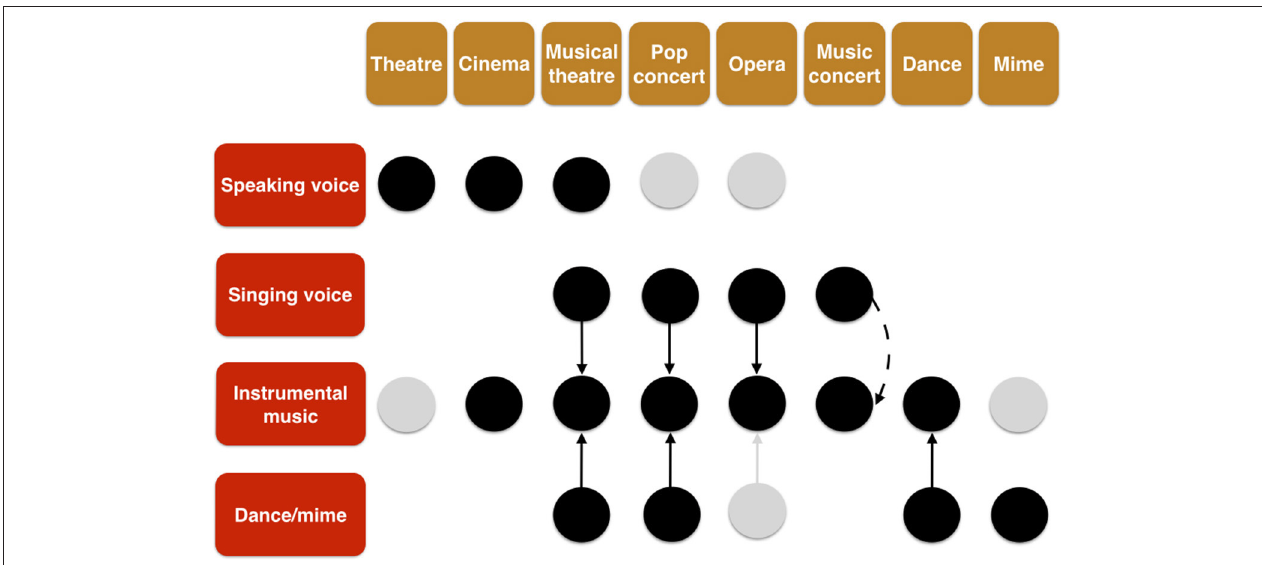
FIGURE 3 | The performing arts with respect to performance modalities. The figure shows eight forms of the performing arts along the top. These are then classified with respect to their inclusion of four performance modalities: the speaking voice, the singing voice, instrumental music, and dance (and/or mime). Black circles imply the presence of a given modality in a given artform. The vertical arrows suggest that singing and dancing are very often done to the beat of instrumental music in these artforms. The dashed arrow for “music concert” implies that singing can be done either a capella or to instrumental accompaniment; likewise, instrumental music can be performed all on its own. Performance art (not shown here) sits in the categories represented by dance and mime. Gray circles imply secondary uses of modalities. These include the occurrence of instrumental underscore in theater works, spoken segments in pop concerts and opera, dance segments in opera, and instrumental underscore in pantomime